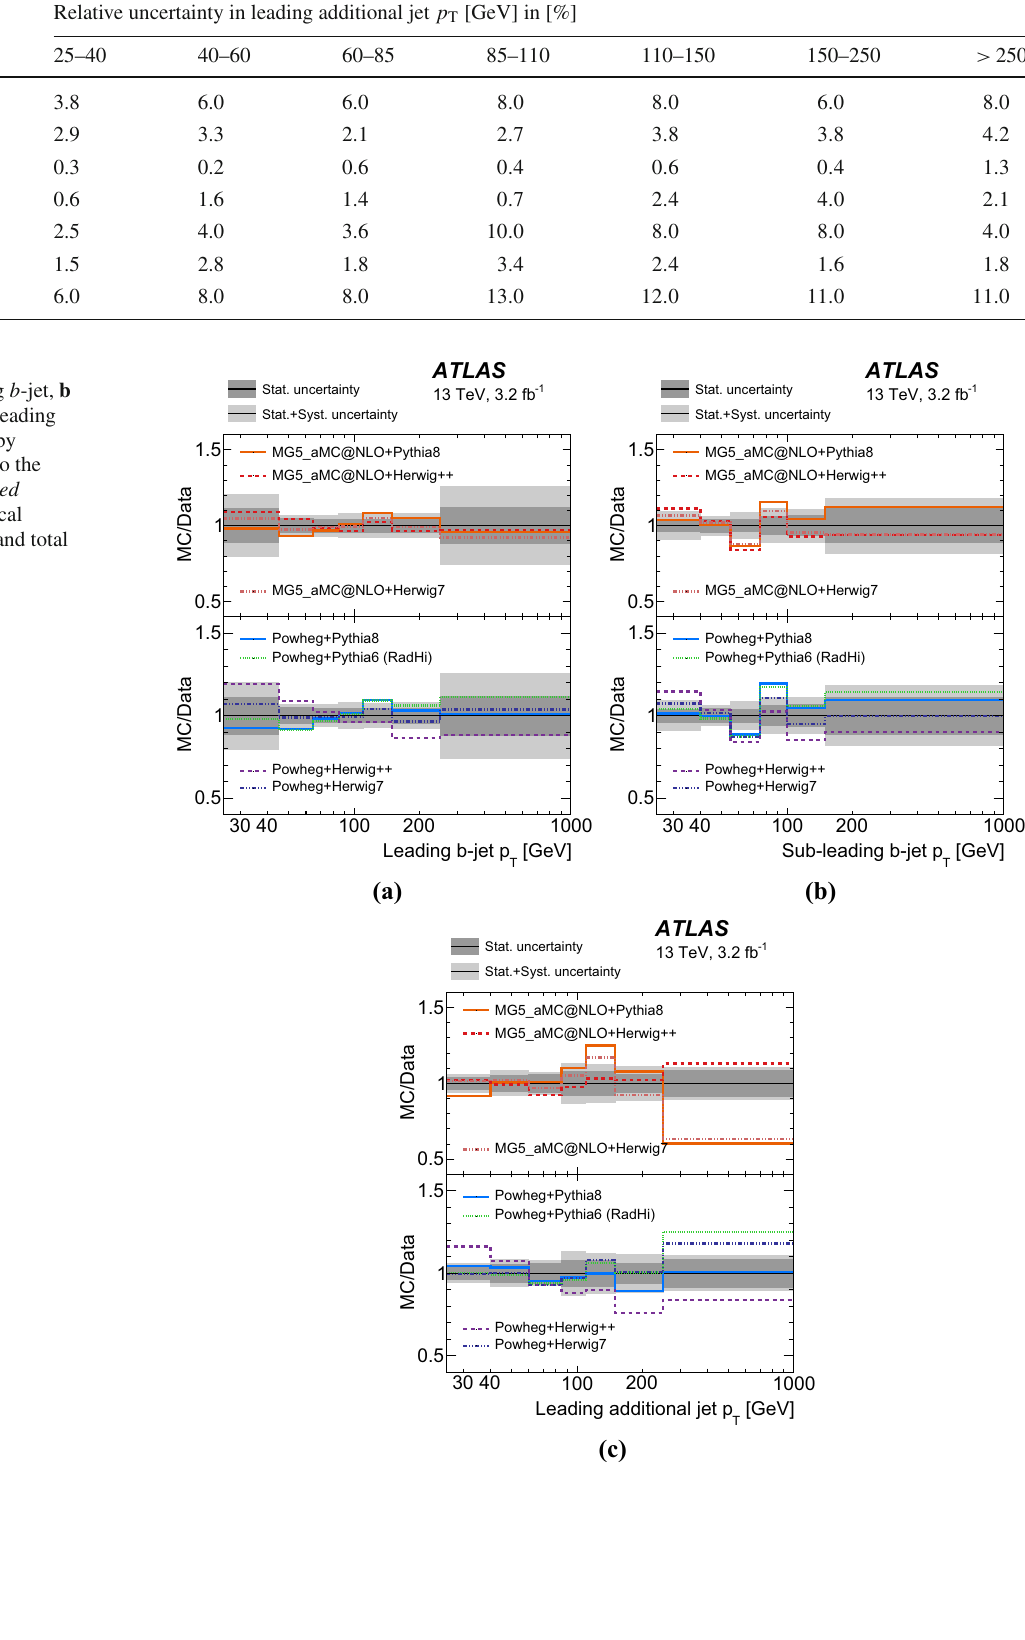
Table 9 Summary of relative measurement uncertainties in [%] for the leading additional jet p T distribution. “Signal modelling” sources of systematic uncertainty includes the hadronisation, parton shower and